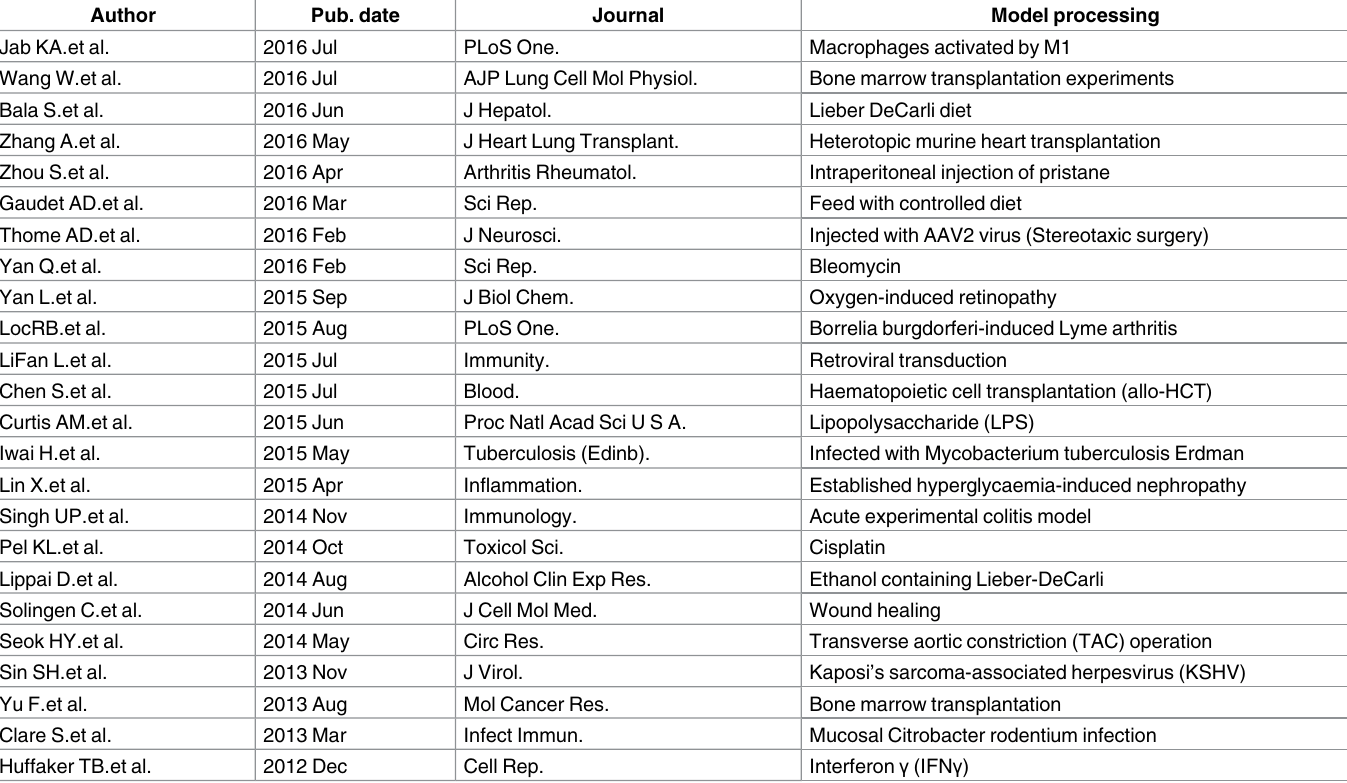
Table 9. Summaryof pertinent miR-155(-/-) mouse modelling